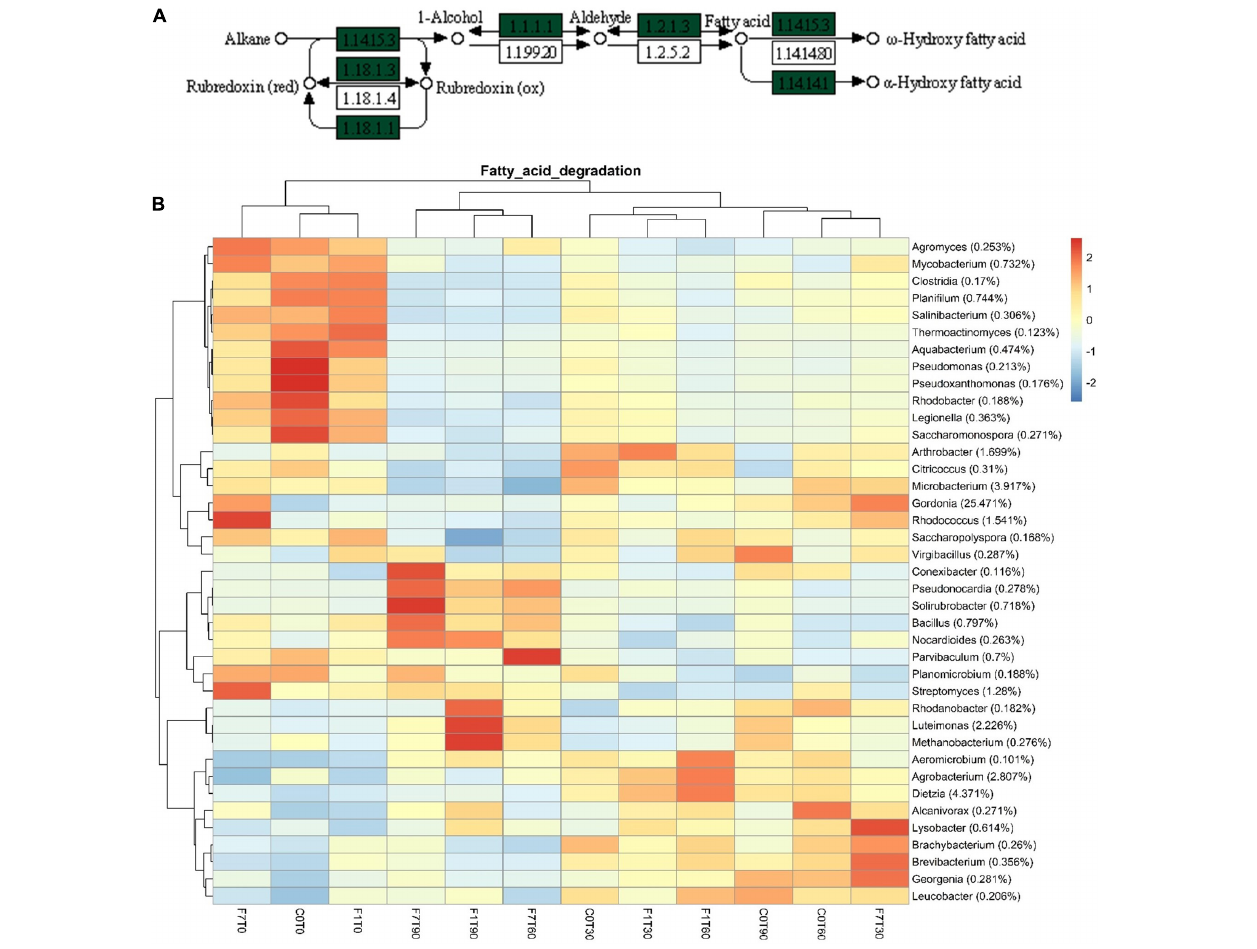
FIGURE 10 | (A) Particular of fatty acid degradation pathway map (map00071) depicting aliphatic hydrocarbon degradation. Green labels indicate the presence of enzymatic features among those inferred in metagenome. (B) Heatmap showing bacterial contributions to fatty acid degradation pathway in metagenome, as calculated by iVikodak server, with a PEC of 80%. Reported taxonomic resolution is genus level, with a cut-off of 0.1%. Hierarchical clustering was performed on both rows and columns by Pearson correlation, based on Euclidean distance. Color scheme represents row-wise Z-scores of contribution counts per ASV. Percentage reported near ASV names represents the relative abundance of the sum of ASV contributions per sample against total sum (i.e., Z = 0 matches reported